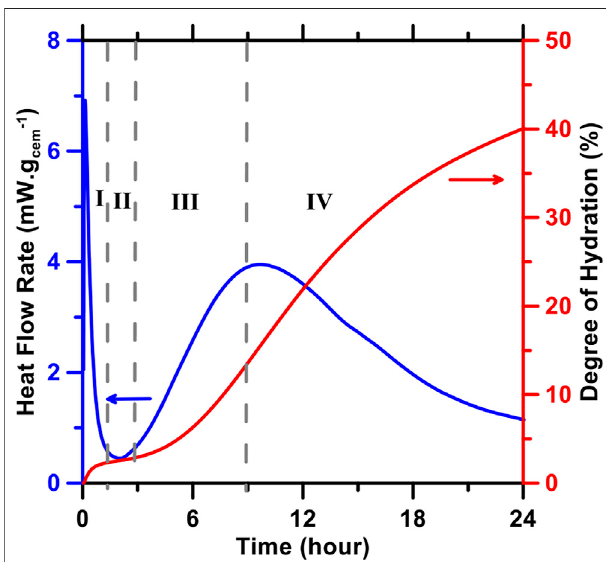
FIGURE 1 | Heat fl ow rate pro fi le (blue), depicting the kinetics of PC hydration during four stages that manifest within the fi rst 24 h after mixing (I) initial period (II) induction period (III) acceleration period ; and (IV) deceleration period (Bullard et al., 2011; Cook, 2020; Cook et al., 2021b). The initial period corresponds to wetting of PC particulates (upon contact with water) and their rapid dissolution. The induction period corresponds to a period of slow dissolution of PC particulates, and precipitation of small amounts of hydrates (Bullard et al., 2011; Scrivener et al., 2015). The acceleration and deceleration periods are associated with a short burst of nucleation and subsequent growth of hydrates (Bullard, 2008; Bazzoni, 2014; Bazzoni et al., 2014;Bullardetal.,2015;Scriveneretal.,2015).Theheat fl owratepro fi lecan beusedtoestimatethetime-dependent extent/degreeofreaction